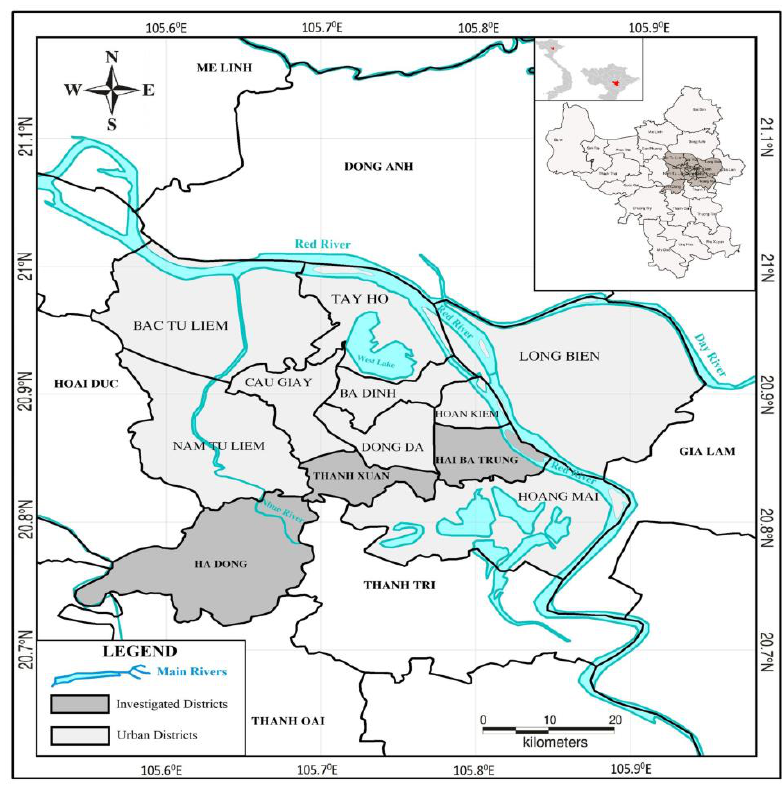
Figure 1. Study area and main rivers in Hanoi. Hanoi’s Urban Domestic Water Supply System (HUDWSS) faces a number of